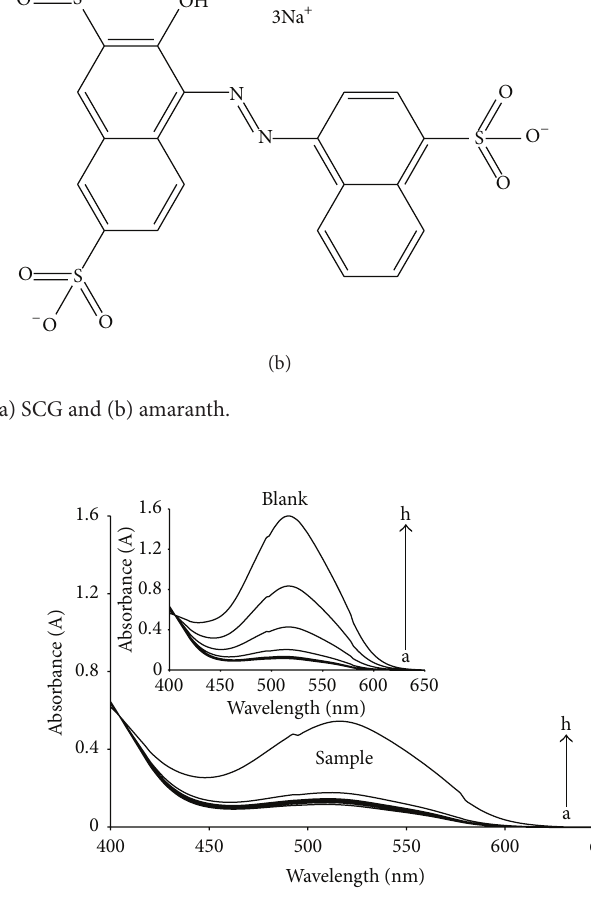
Figure 2: Absorption spectrum for the SCG-amaranth-IO 4− system with time. Conditions: H 2 SO 4 , 2.4mol L −1 ; SCG; 12 ngmL −1 ;